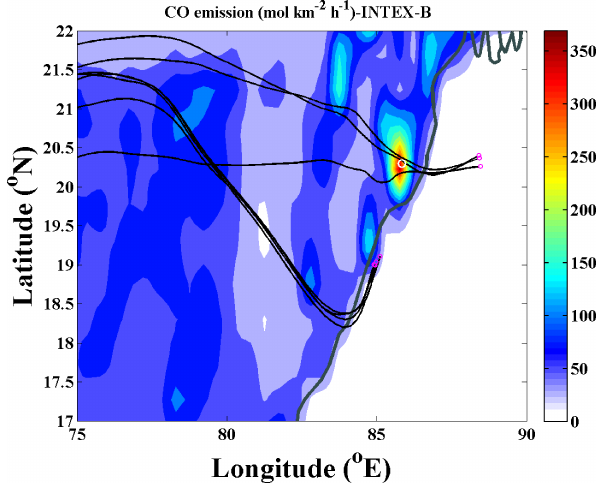
Figure 6. Spatial distribution of column-averaged CH 4 for the month of August 2009 as obtained from